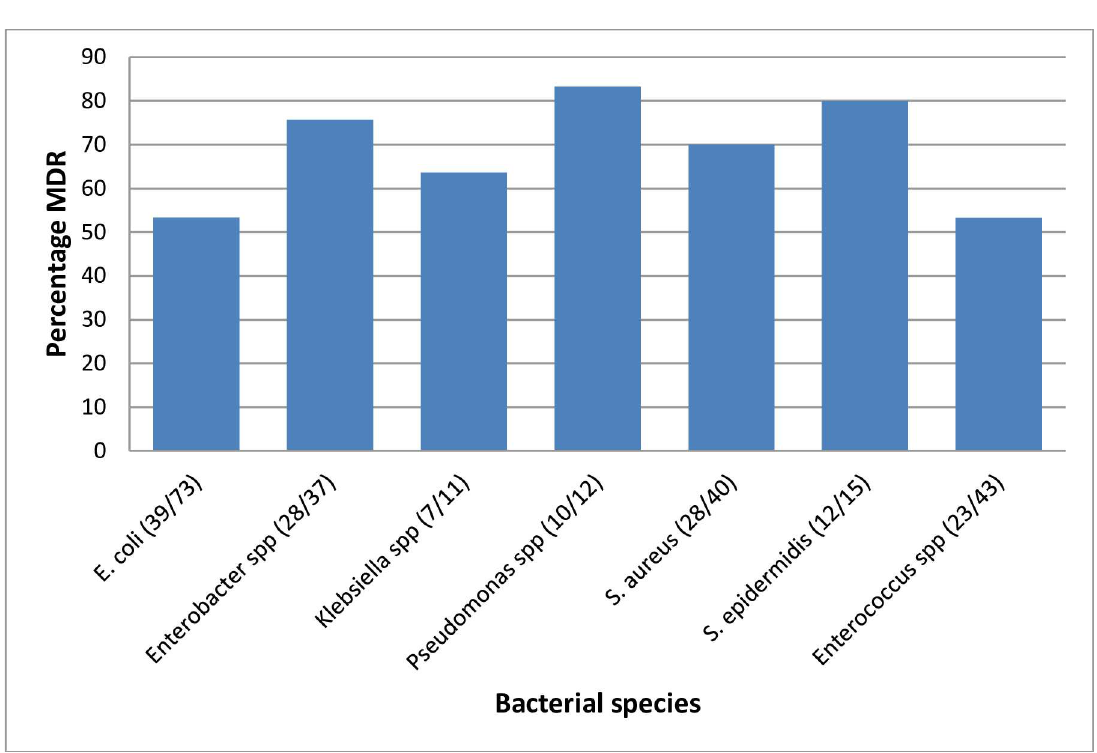
Fig 2. Showing multi-drug resistance of the bacterial isolate from urinary catheter tips of post-partum women.